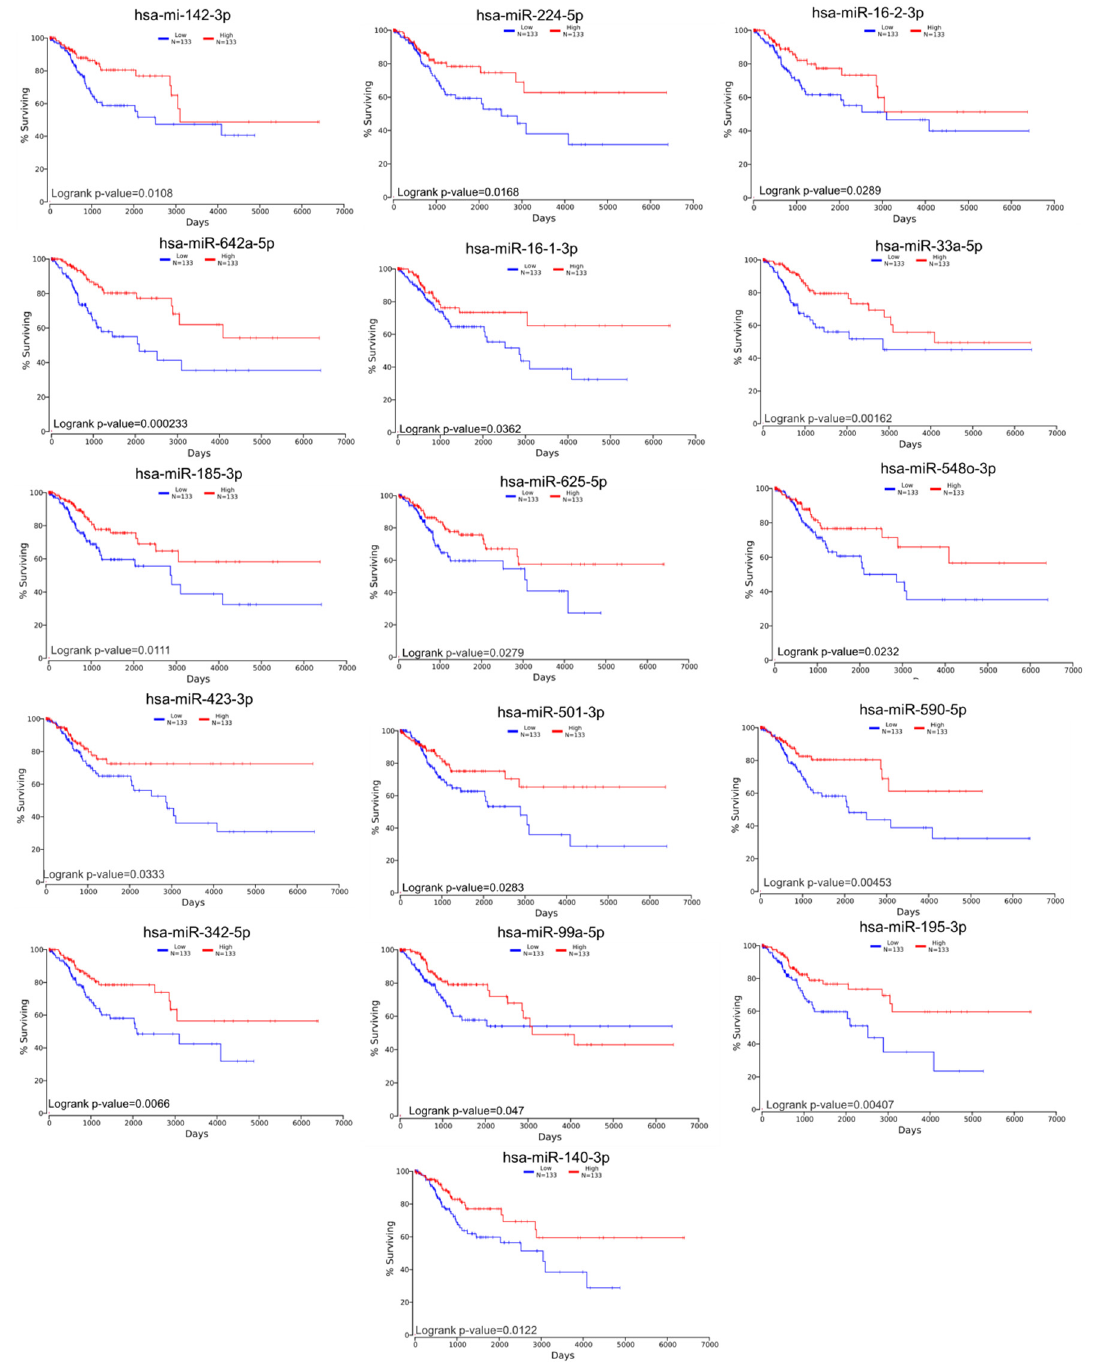
Figure 9. Altered miRNAs in CC predicting overall survival rate.